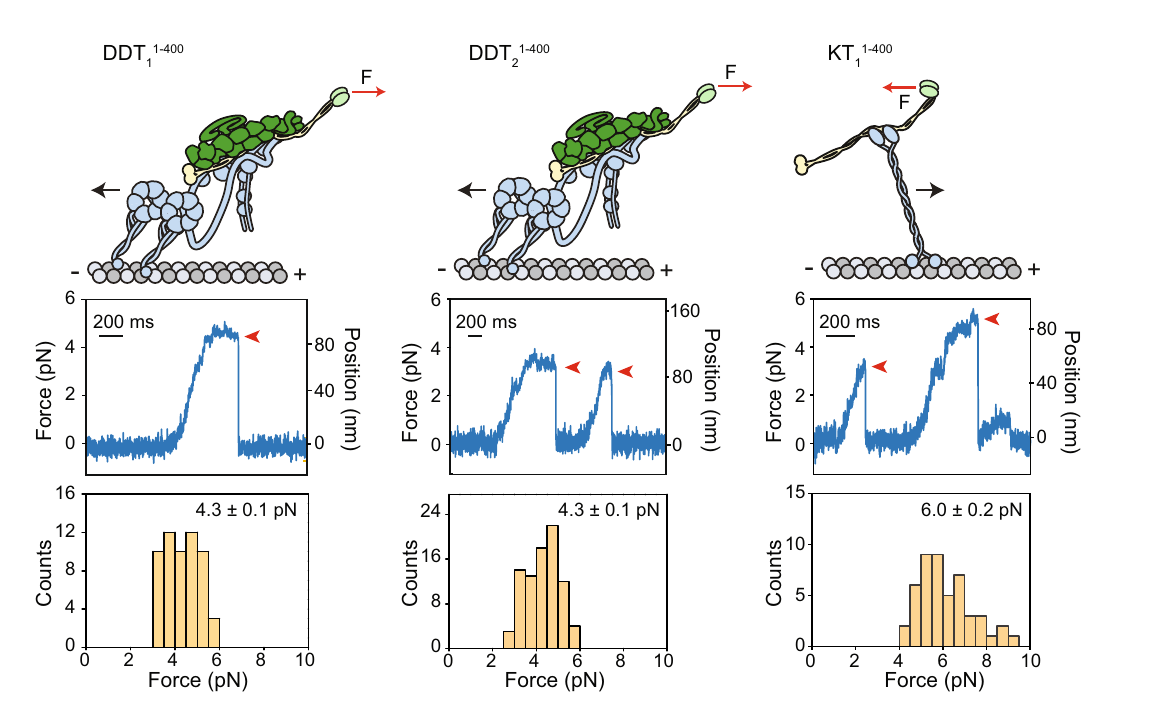
Fig. 3 | Force generation of dynein-dynactin or kinesin assembled with TRAK adaptors. (Top)SinglemotorcomplexeswerepulledfromtheTRAKadaptorbyan optically trapped bead (not shown; F: force). (Middle) Representative traces of beads driven by a single KT or DDT complex in a fi xed-trap assay. Red arrowheads represent the detachment of the motor from an MT after the stall. (Bottom) Stall